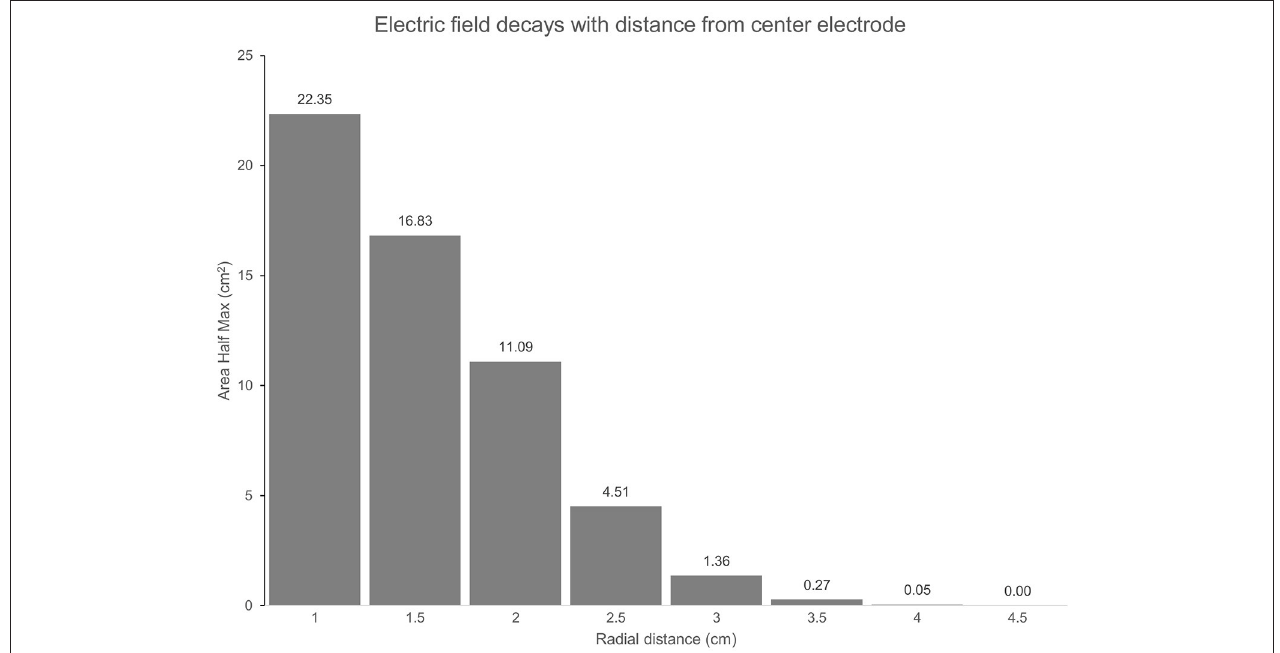
FIGURE 3 | (TPJ Spread): The Area at Half Maximum (AHM) of the cortical electric field quantifies the spatial focality of the semicircular 3 × 1 HD-tDCS montage relative to the center electrode. In total, an area of 26 cm 2 is above half the maximum E-field for each montage. As radial distance on the cortex below the center electrode increases, more of the AHM is excluded. At a 3cm radius 5.23% (1.36 cm 2 ) of the AHM remains, 0% is beyond 4.5cm.